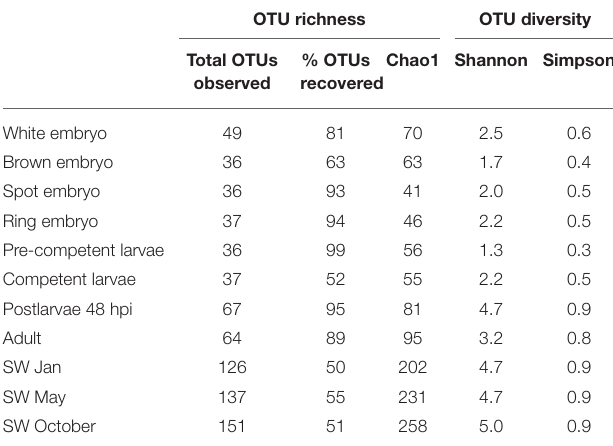
TABLE 2 | Observed number of operational taxonomic units (OTUs) and estimation of richness (Chao1) and diversity (Shannon, Simpson) obtained from rarefied